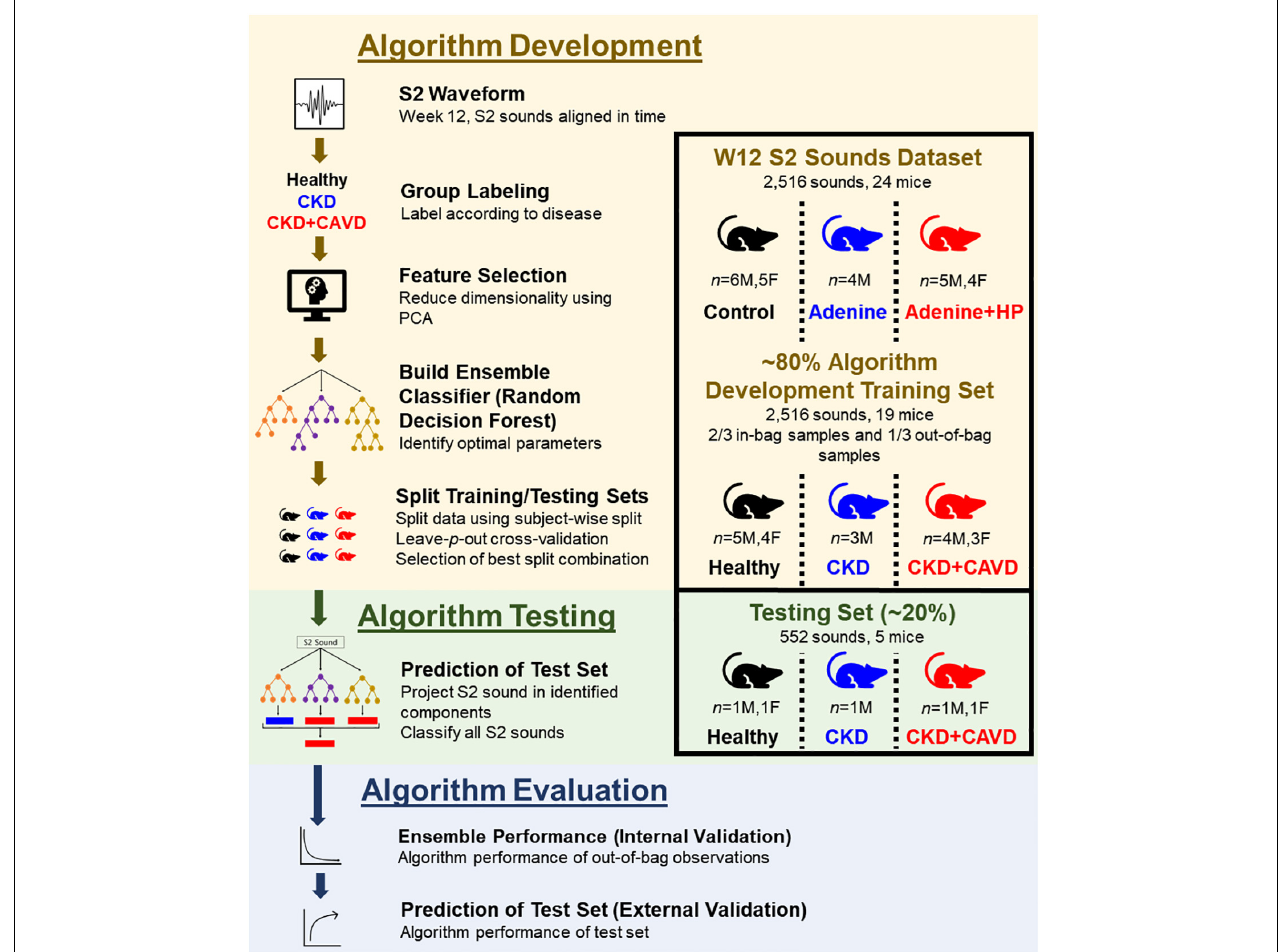
FIGURE 3 | S2 heart sound classification algorithm. Development of algorithm to identify the presence of AoV calcification using the S2 sound in a mouse model of CKD-induced